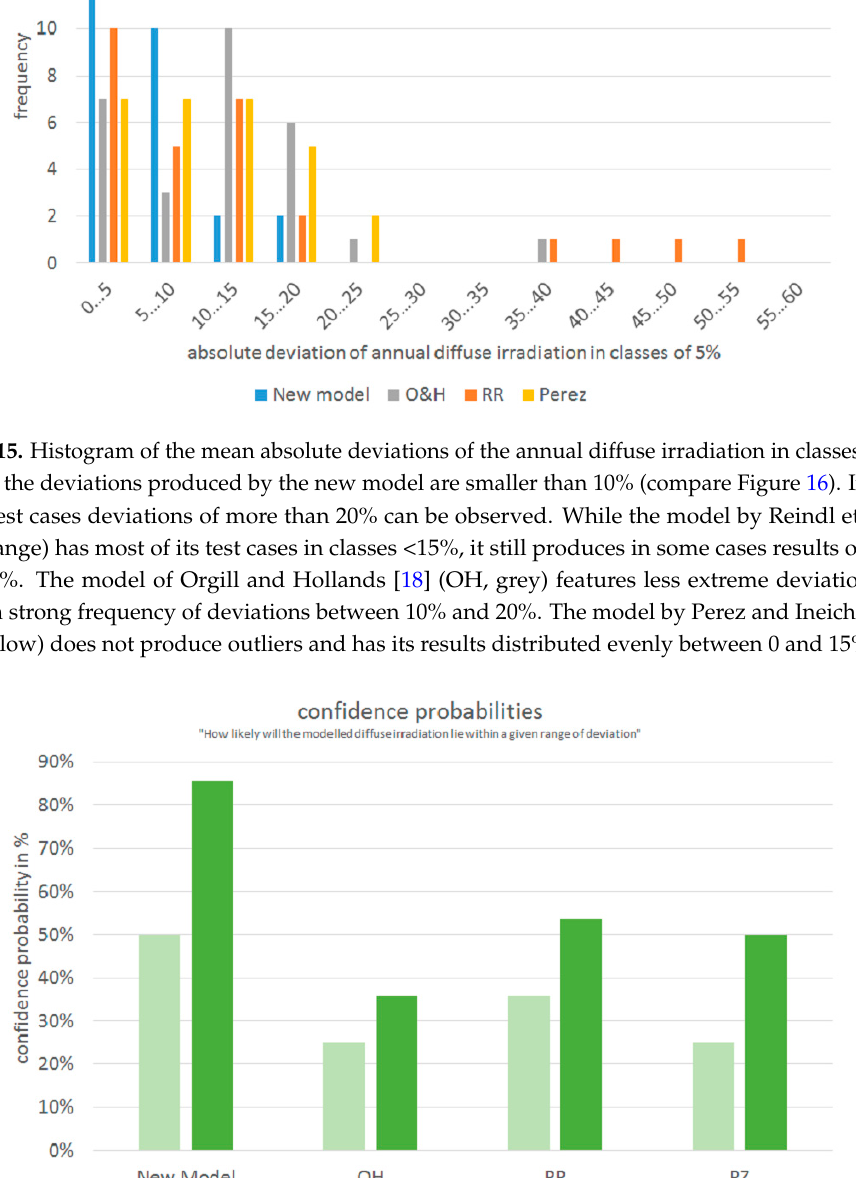
Figure 16. When using the new model for calculating the diffuse irradiance, the annual deviation of the modelled irradiation will be smaller than 5% in more than 40% of the cases, and smaller than 10% in over 80% of the cases. When using the model of Orgill and Hollands [18] (OH), these confidence probabilities reduce to 25% and 36%, while using the model of Reindl et al. [3] (RR) reduces the probabilities to 36% and 54% respectively. The use of the model of Perez and Ineichen [23] (PZ) results in probabilities of 25% and 50%.